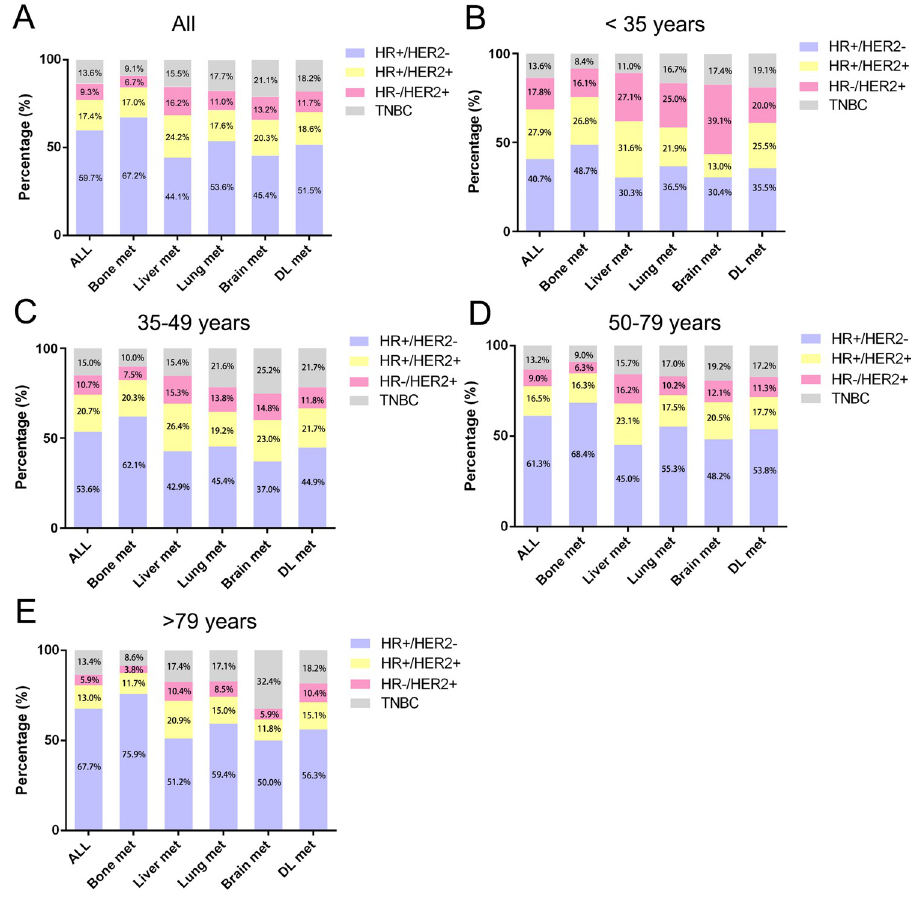
Fig 4. Distribution of molecular subtypes in MBC patients with different age. ( A ) All patients; ( B ) Younger patients ( < 35 yrs); ( C ) Middle-aged patients (35–49 yrs); ( D ) Middle-aged patients (50–79 yrs); ( E ) Older patients ( > 79 yrs).